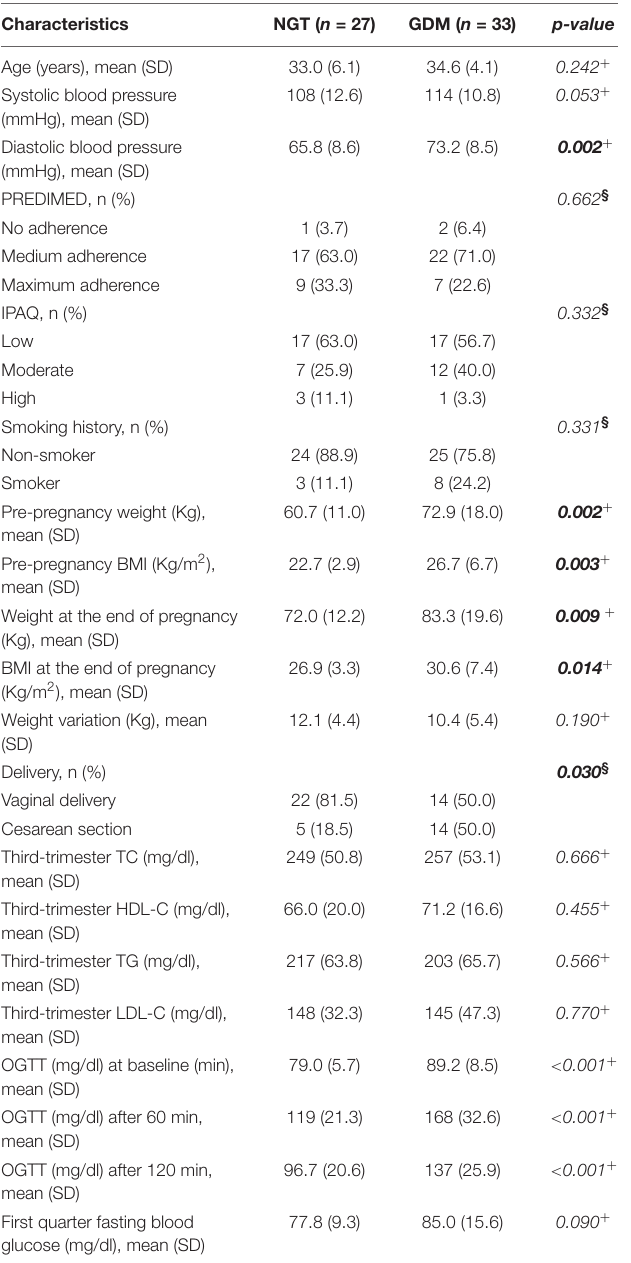
TABLE 2 | Neonatal outcomes relative to normoglycemic (NGT) and gestational diabetes (GDM) women expressed as mean and standard deviation (SD) absolute frequency (n) and column percentage (%).